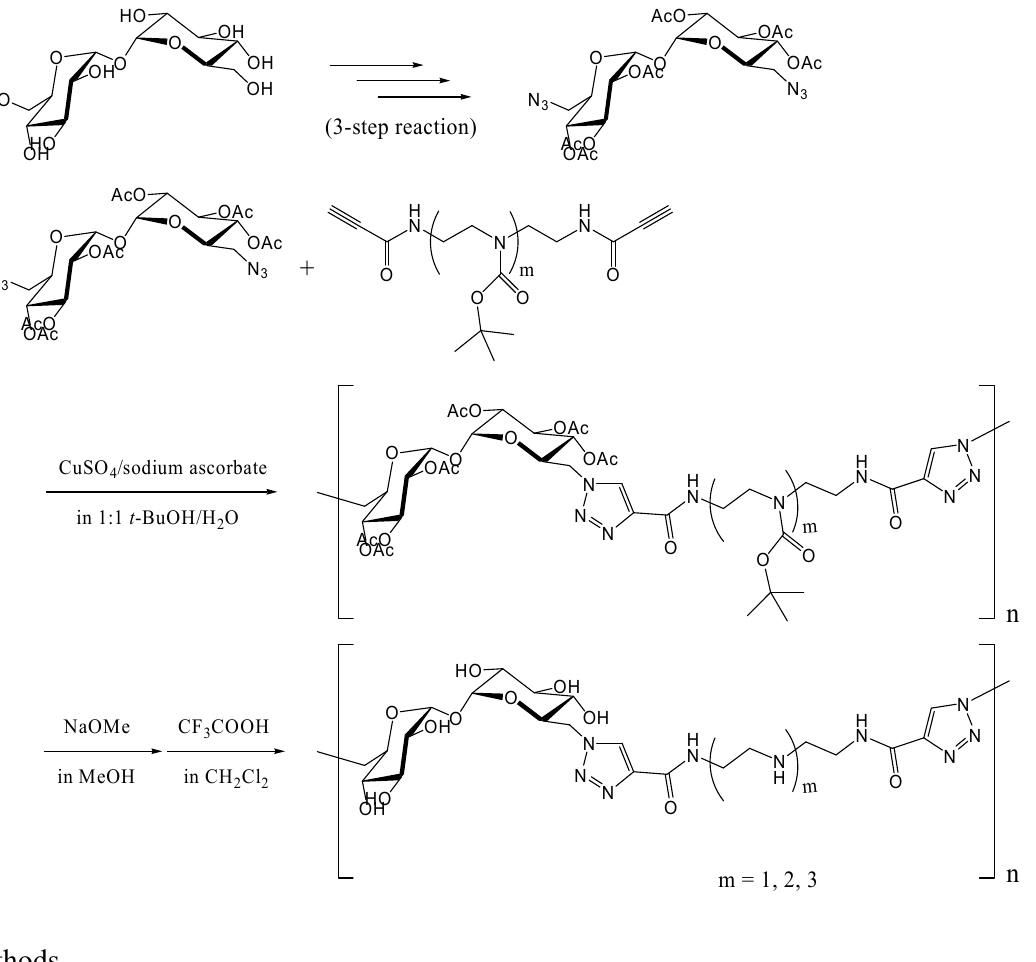
Figure 19. Synthesis of trehalose-based polymers containing amide-triazole groups by the click